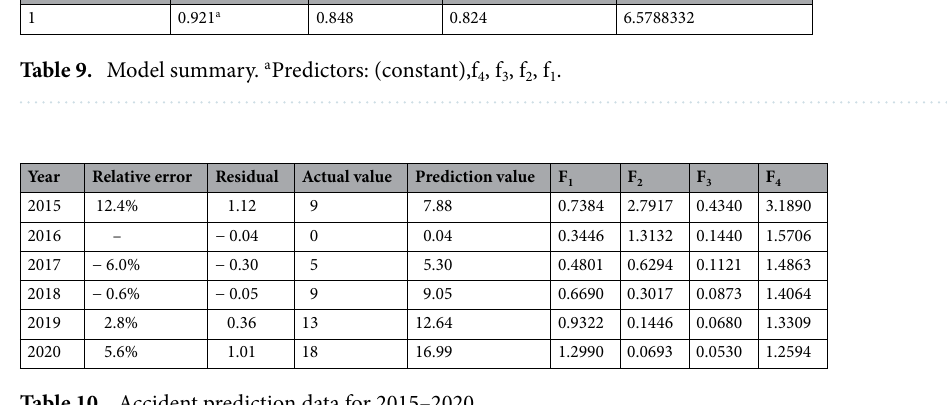
Table 10. Accident prediction data for 2015–2020.